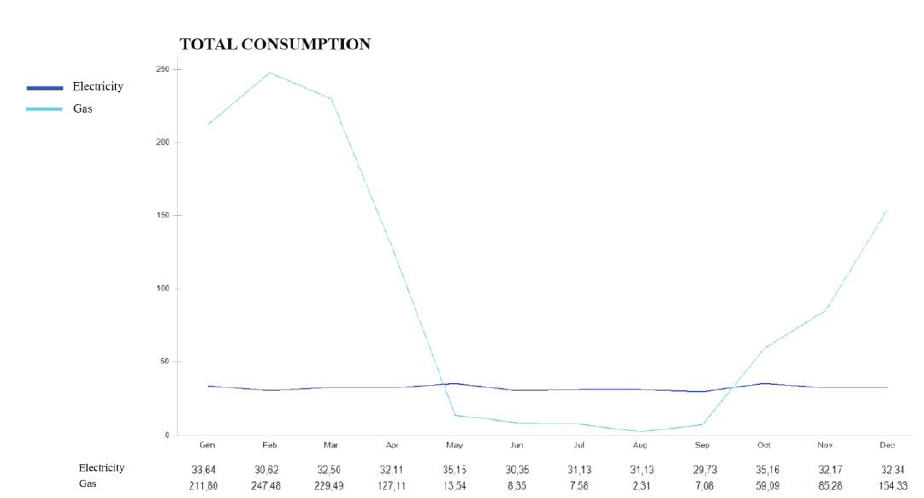
Figure 15. Total consumption graph - electricity and gas.